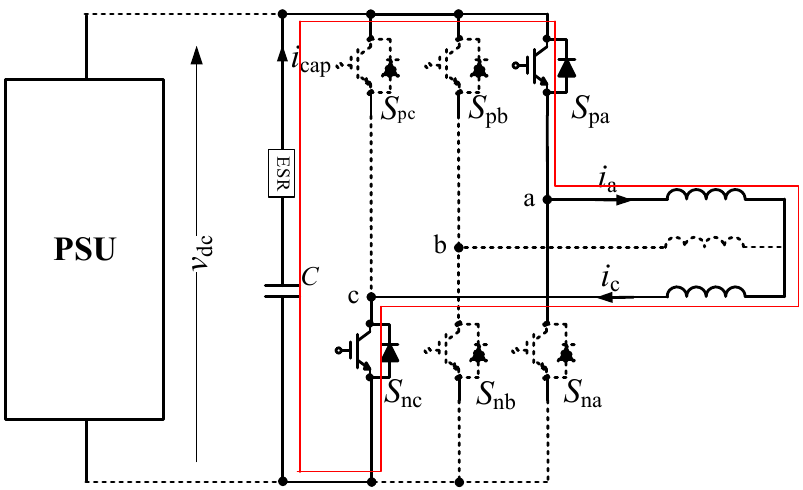
Figure 12. Form of LC resonance in the voltage source inverter (VSI) system.